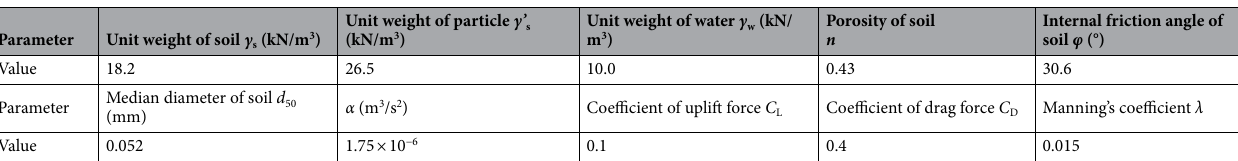
Table 1. Parameters used in the calculation of Eq. (16).